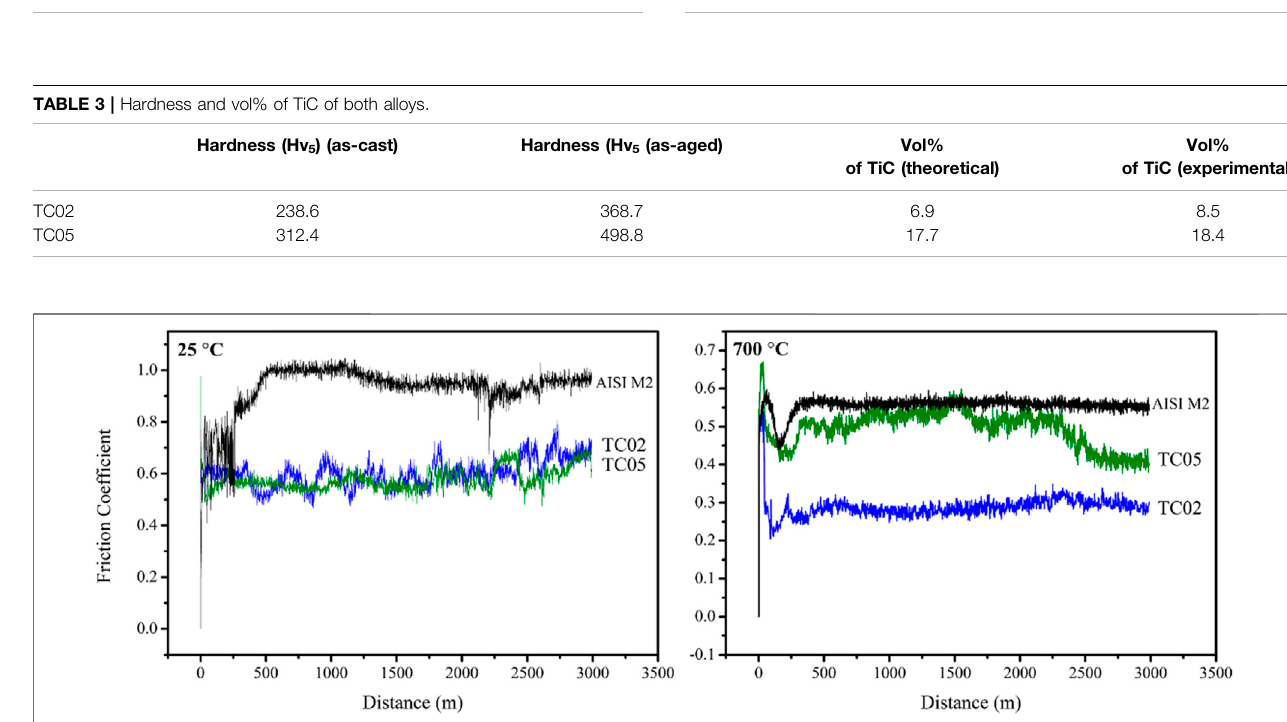
higher than that in TC02 due to the higher content of Ti and C both as-cast and as-aged HEAs are summarized in Table 3 . Figure 2 . The BCC peaks, which correspond to the age- hardening phase, appeared after the aging treatment. The microstructure of both alloys after the aging treatment was similar to their as-cast state ( Figure 3 ), where the matrix was FCC; the gray phase was Cr-rich BCC, and the black particles tended to be TiC, while the black stripe-like precipitates were formed in the matrix of the peak-aged alloys. These precipitates were primarily of the B2-NiAl compound since Ni-Al possesses the highest mixing enthalpy among all elements in the matrix ( Table 4 ); this indicates a tendency to form a Ni-Al compound in the matrix. This could also correspond to the BCC peaks in the XRD patterns and the